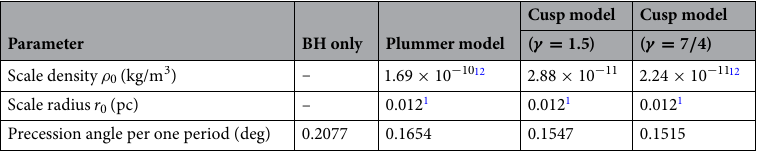
Table 2. Fitted parameters of the S2 orbit for the ‘SMBH model’ and the ‘SMBH+DM’ model.